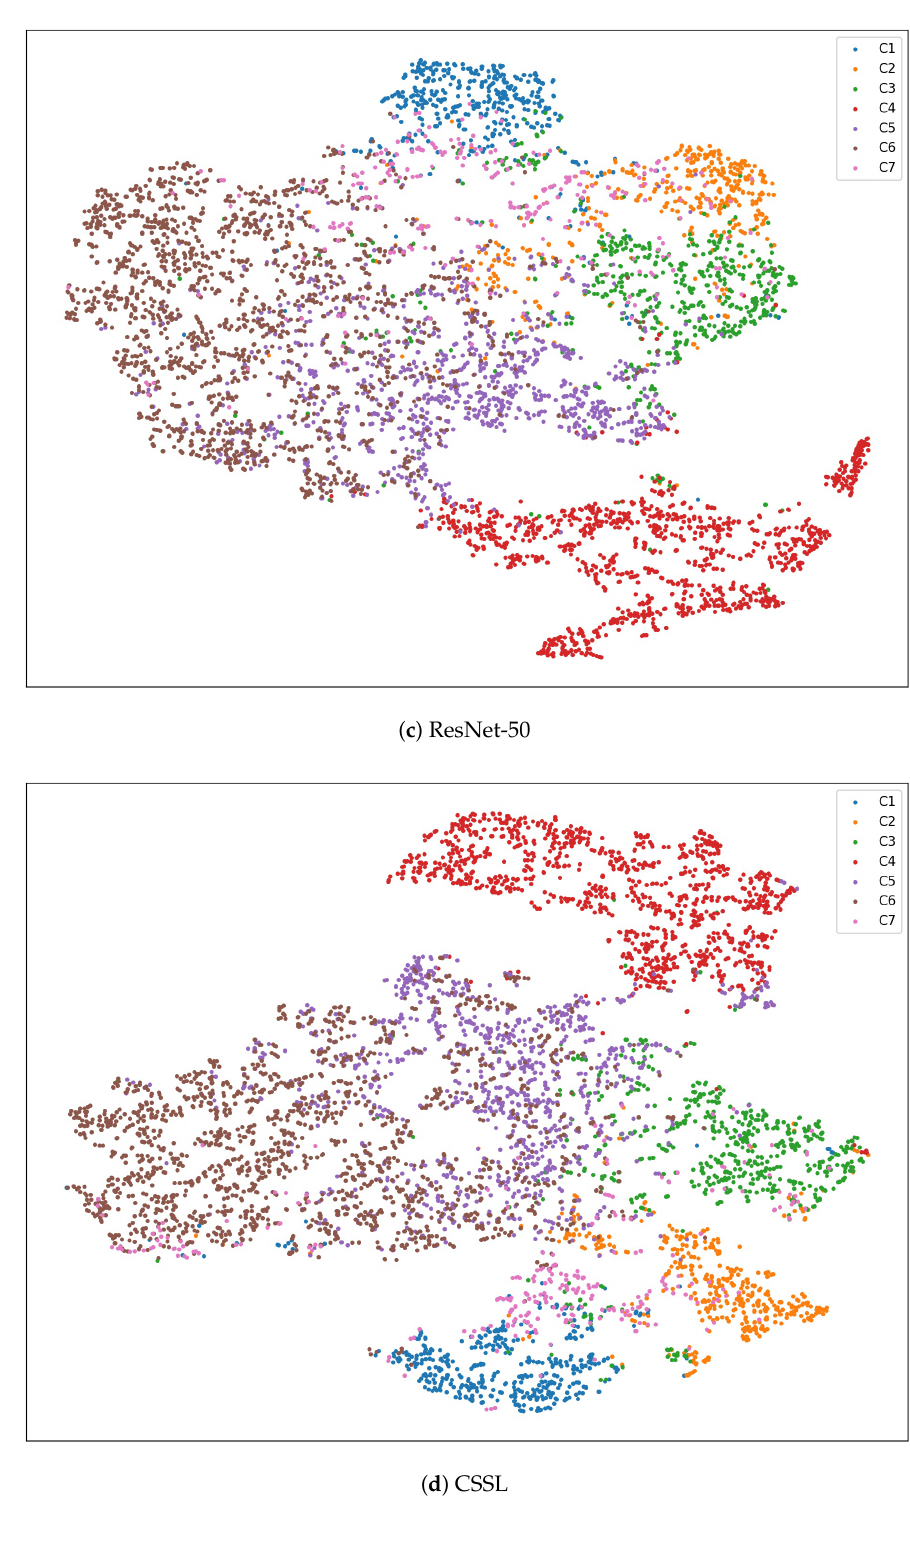
Figure 9. Visualizations of features based on t-SNE [59], in which each dot represents the final feature of the ground-based cloud image, and the types of clouds are indicated by their colors. Feature visualizations of ( a ) CloudNet, ( b ) VGG-19, ( c ) ResNet-50, and ( d )